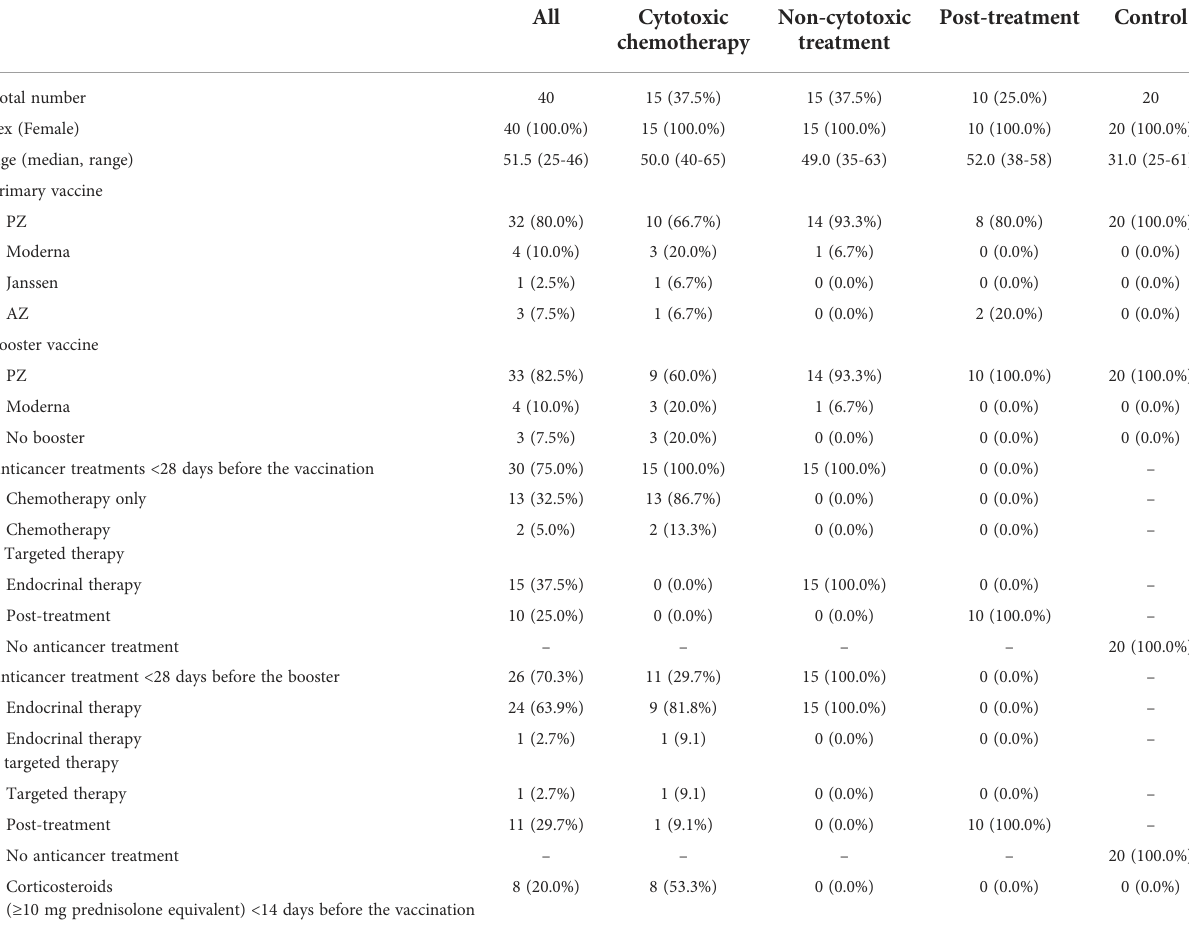
TABLE 1 Detailed clinical information of patients.